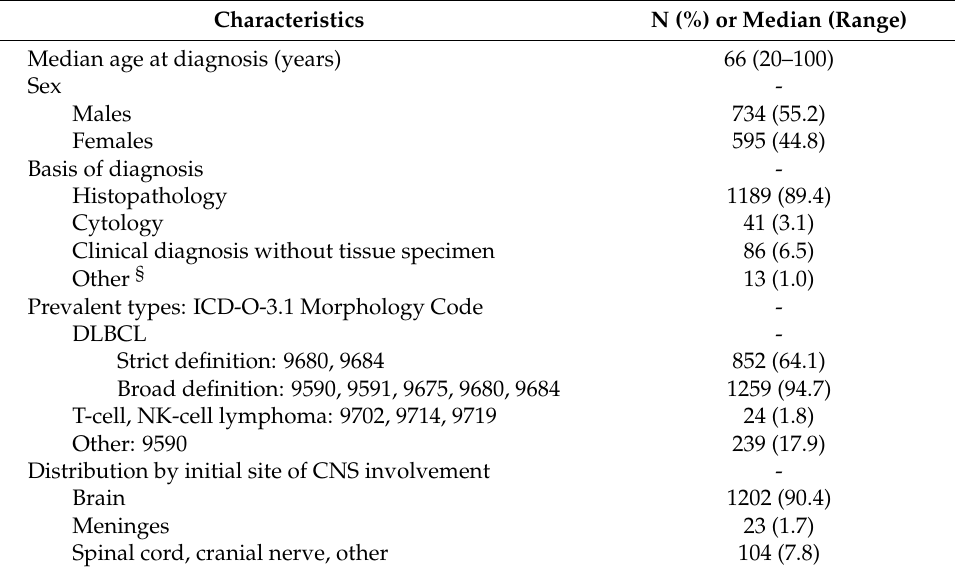
Table 1. Characteristics of the PCNSL cohort sourced from the Australian Cancer Database. n = 1329